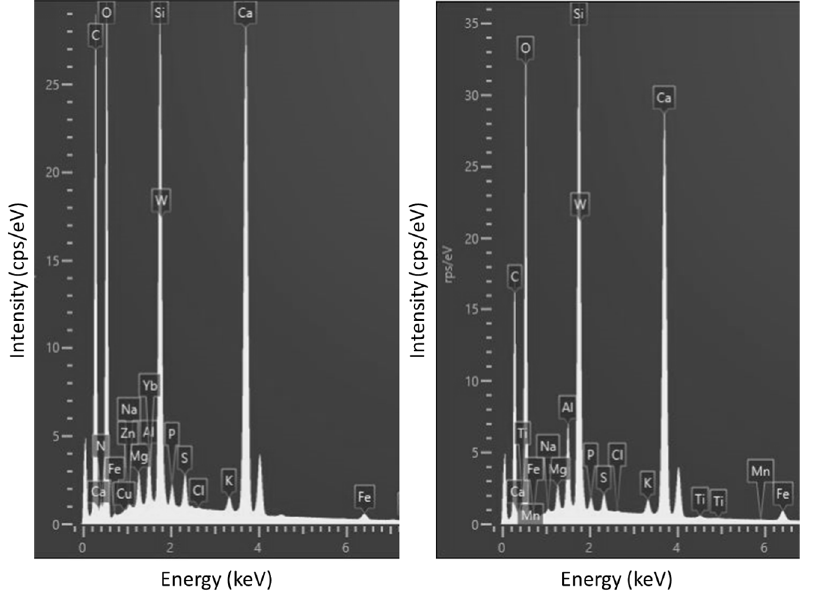
Figure 3. EDS spectra of element content of region 2 on the SP sample on the left and region 1 of the NSP sample on the right.